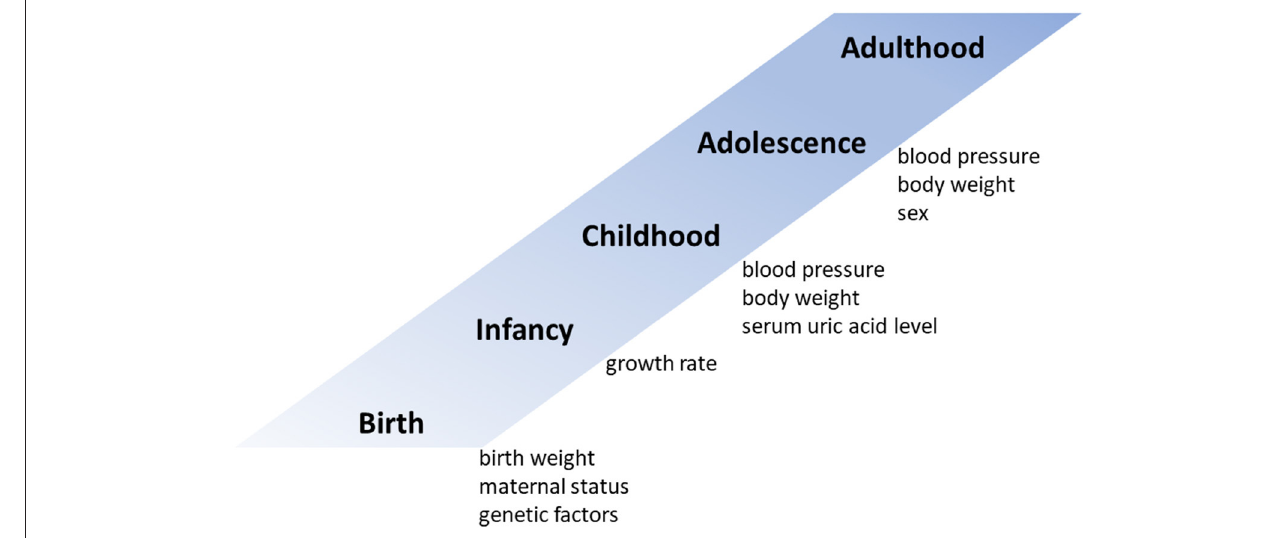
FIGURE 1 | Predictors of blood pressure in